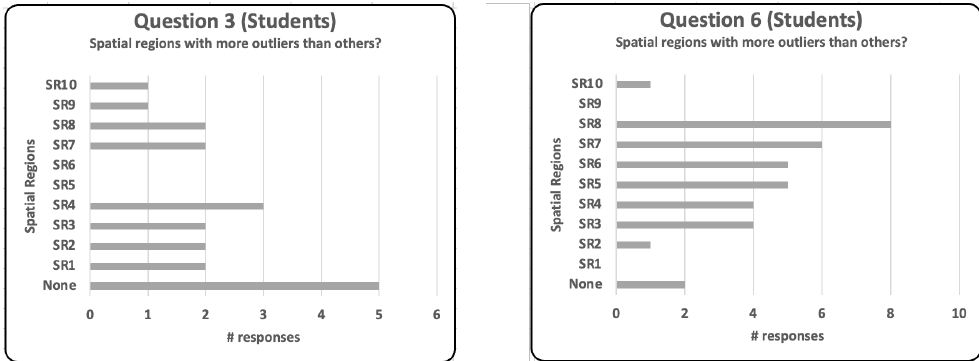
Figure 8. Questions 3 and 6 answers detailed, with the number of users that selected a spatial region as an